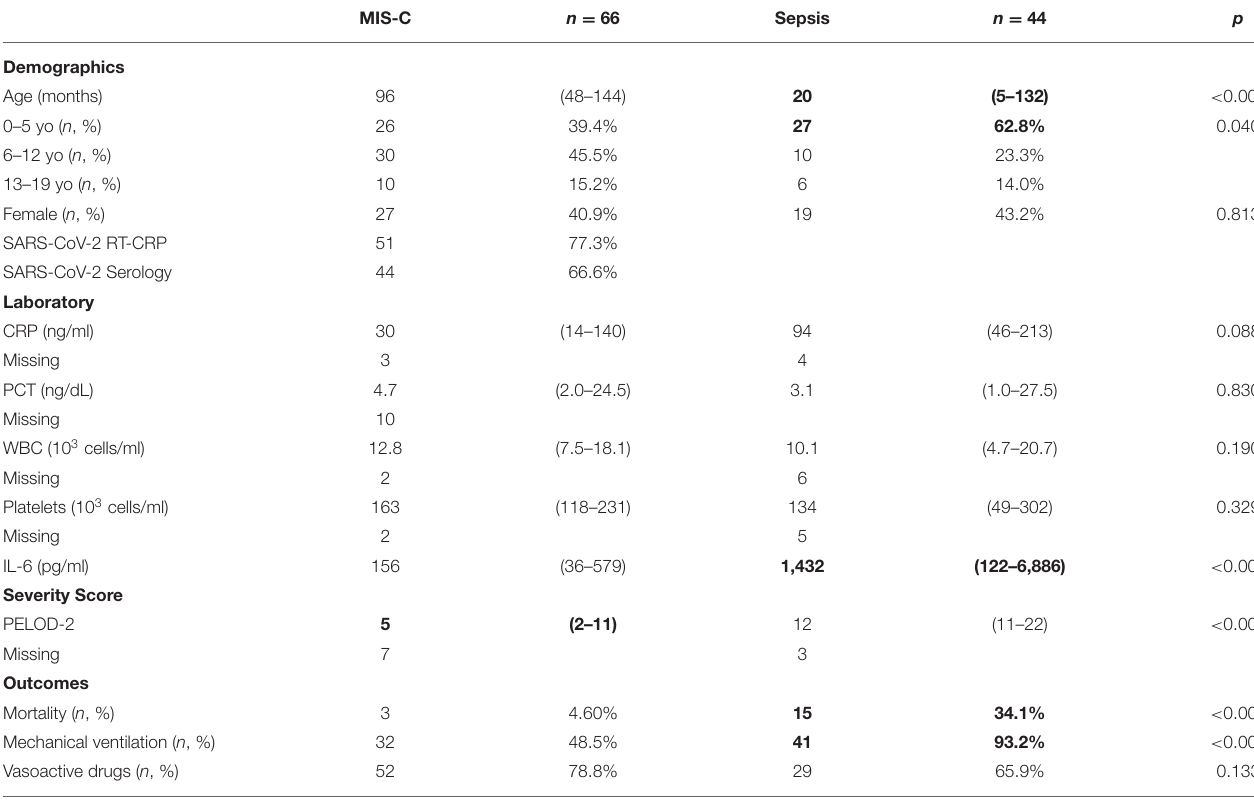
TABLE 1 | Comparative analysis of demographics, laboratory, severity, and outcomes among cases with Multisystem Inflammatory Syndrome in Children (MIS-C) associated with SARS-CoV-2 and pediatric sepsis. MIS-C n = 66